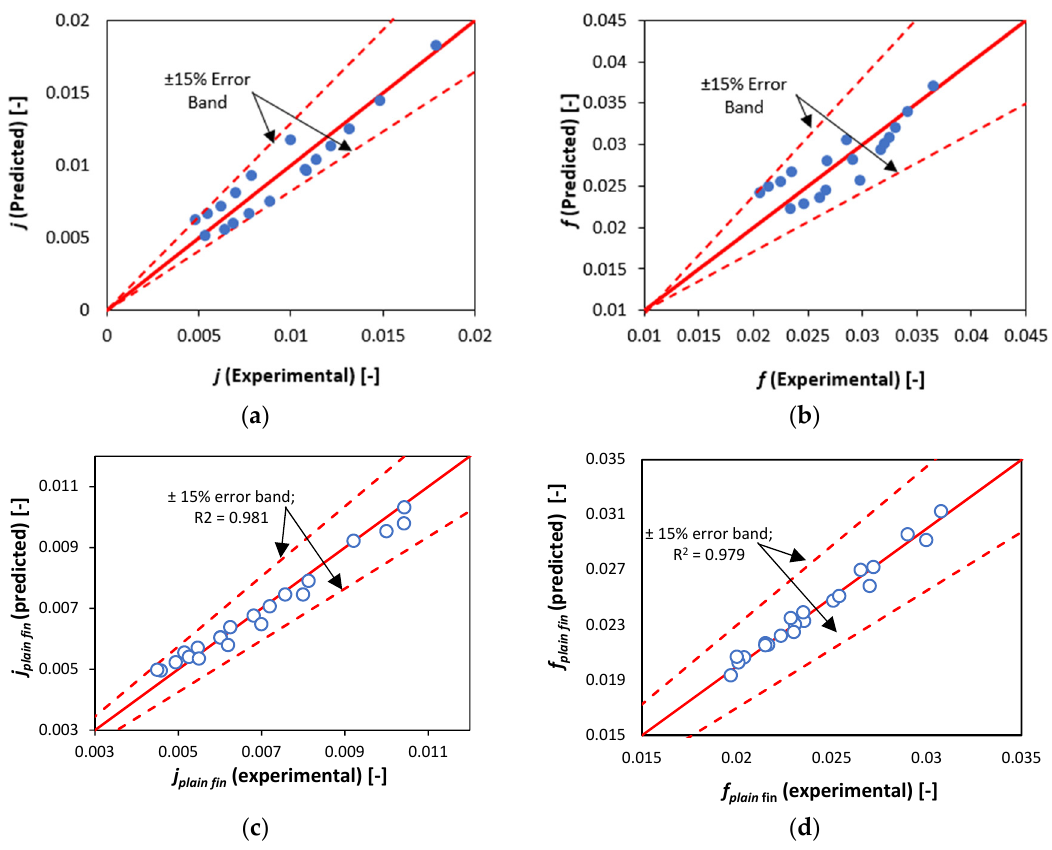
Figure 8. Comparisons of predicted (by Equations (9) and (10)) and experimental values of ( a ) Colburn j-factor and ( b ) Fanning f-factor ( c ) plain fin Colburn factor ( d ) plain fin Fanning factor.